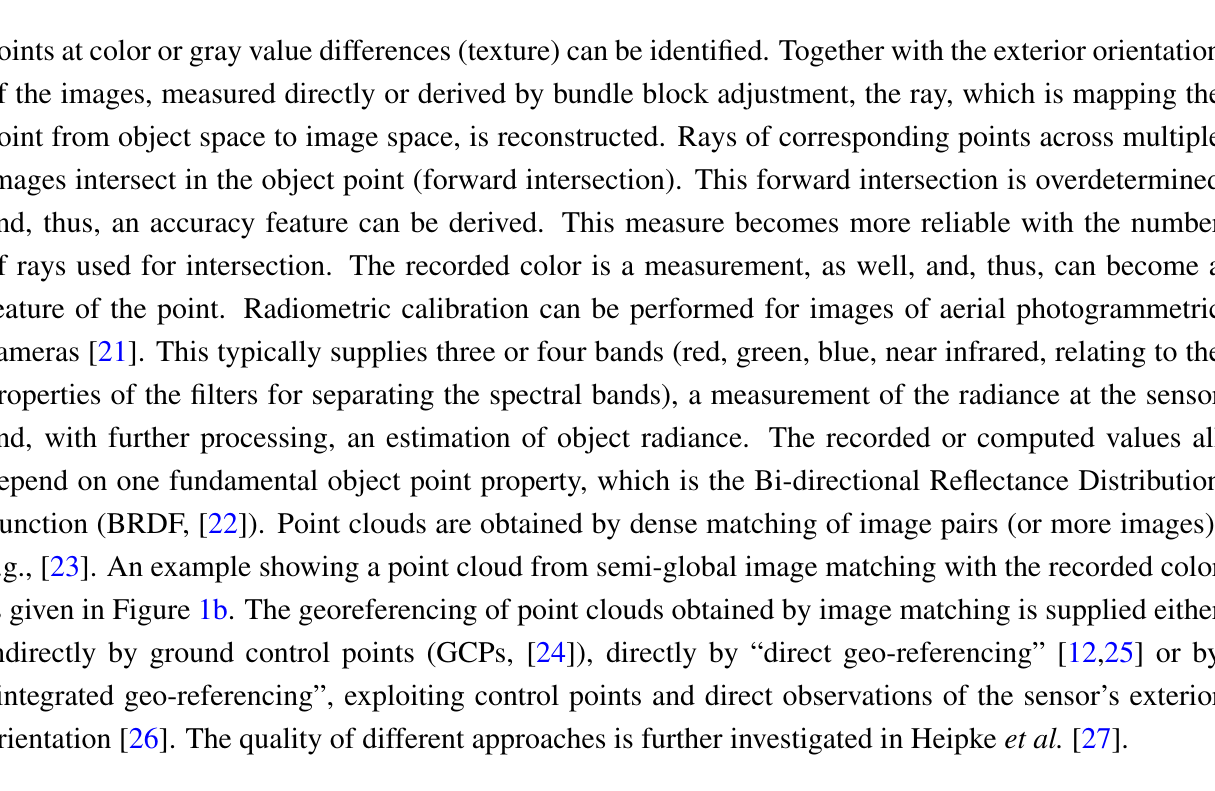
Figure 1. 3D view of point clouds from different data sources. ( a ) Gray scale coded amplitude of LiDAR points; ( b ) colored points from dense